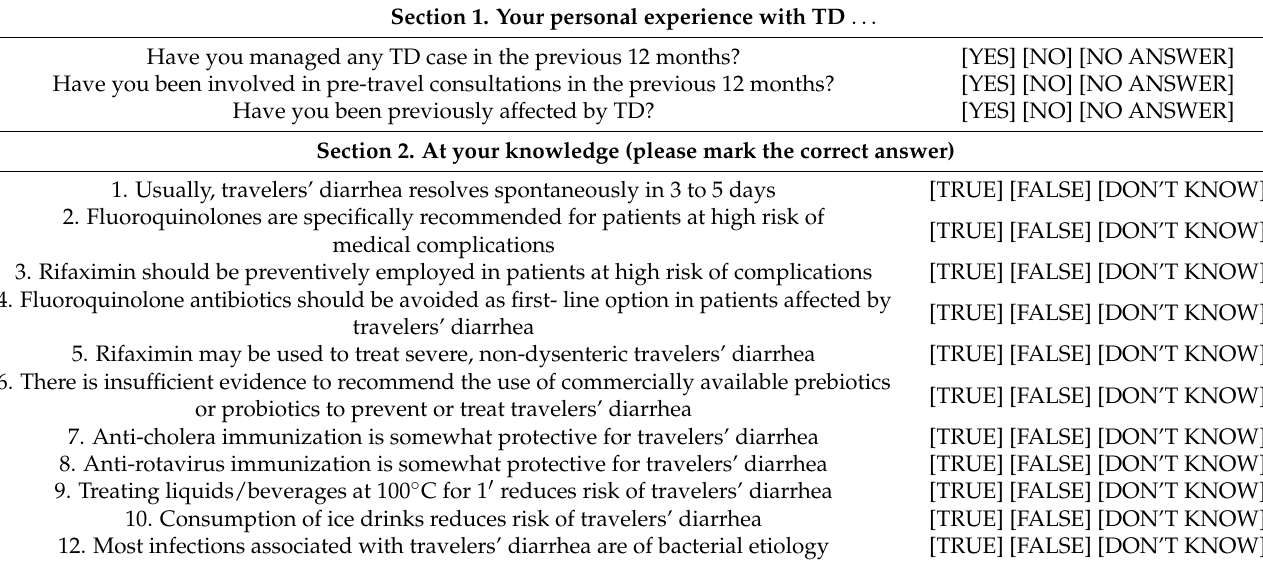
Table A2. Authors’ translation of the items included in the questionnaire. Section 1. Your personal experience with TD . .